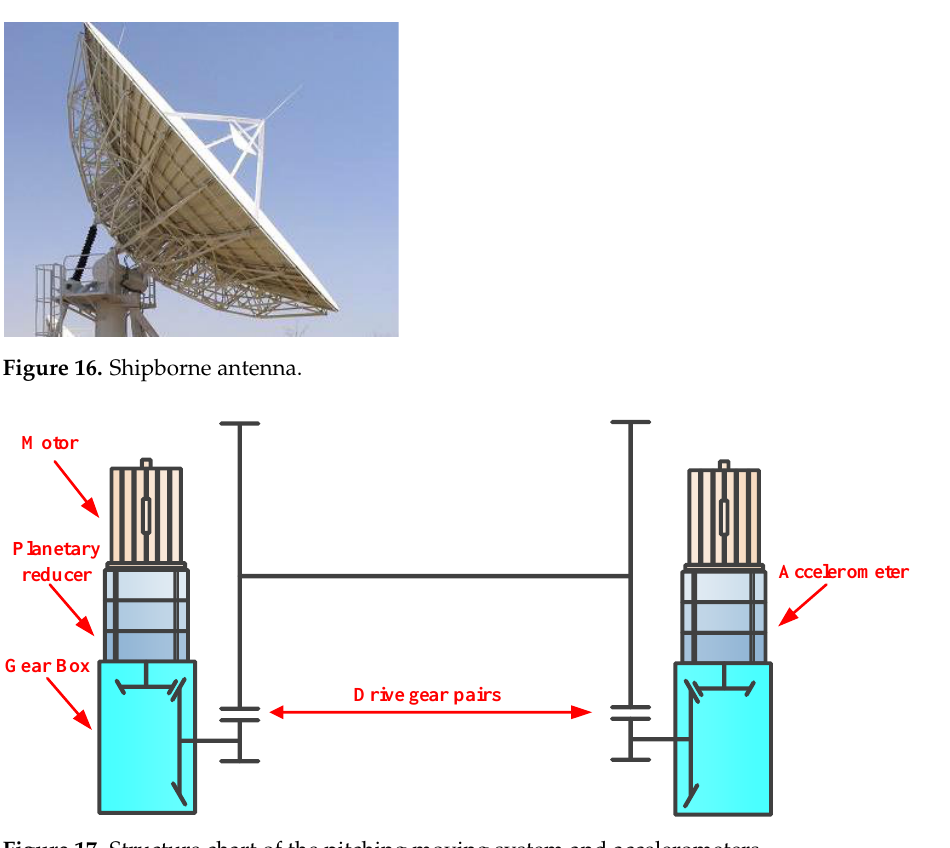
Figure 17. Structure chart of the pitching moving system and accelerometers. Table 2. Characteristic frequency of 6402 deep-groove ball bearing.